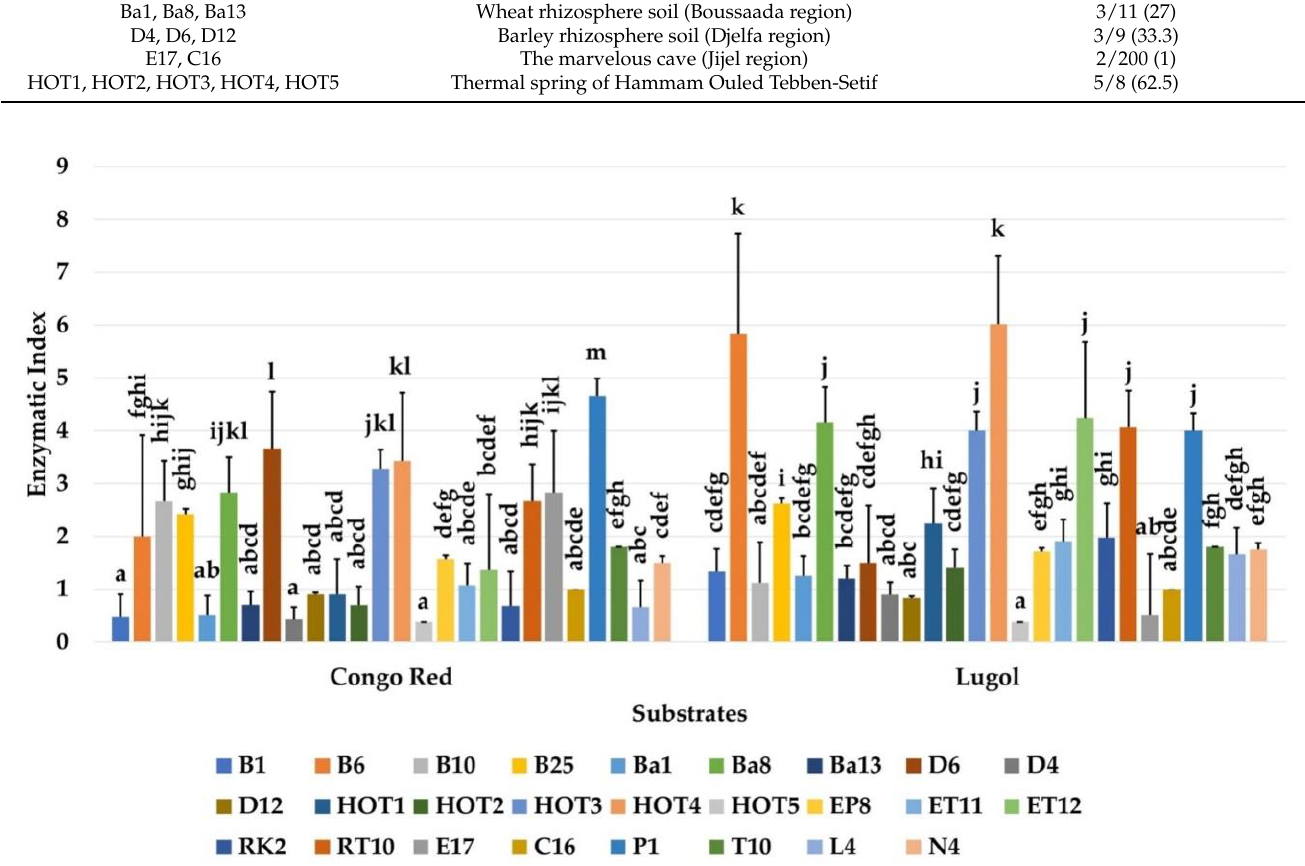
Figure 1. Enzymatic index of CMCase activity in CMC agar (1%) of the 26 isolates revealed by Congo red and Lugol solutions. The results are expressed as the mean ± standard error of the values of the enzymatic indexes in duplicate. The effects of the revelators corresponding to each treatment and not sharing the same letters are significantly different according to Tukey ’ s post hoc HSD test.